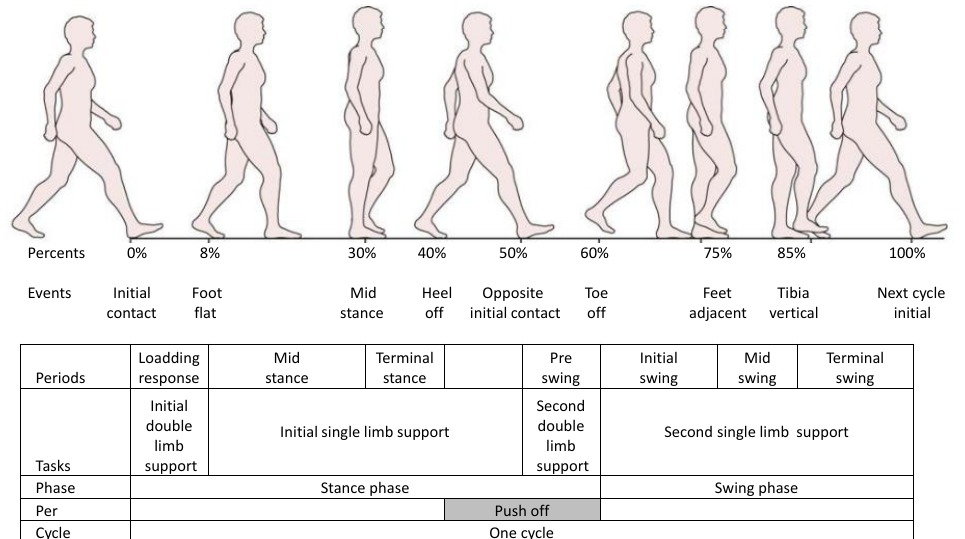
Figure 1. A gait cycle is described as a dynamic and continuous occurrence of eight phases from the heel-contact at 0% to the next heel-contact at 100% percent of the gait cycle. Phase 0 is initial double-limb support, which appears during the first 10% of the cycle. Phase 1 is mid-stance, which appears from 10% to approximately 30% of the gait cycle. The following 10% of the gait cycle is terminal-stance. The propulsion phase or toe-off occurs after foot flat from 40% of the gait. This stage pushes the body forwards and prepares for swing phase from approximately 60% of the gait cycle. Single-limb support occurs from foot flat until 50% of the gait-related opposite initial contact limb, typically at 50% of the gait cycle. The second double-limb support occurs from the opposite limb at 50% until the toe leaves the ground at 60% of the gait cycle. Then, the second single-limb support completes the cycle. The following phases are early swing at approximately 60% to 75% of the gait cycle, mid swing at approximately 75% to 85% of the gait cycle, and late swing at approximately 85% to 100% of the gait cycle. Adapted from